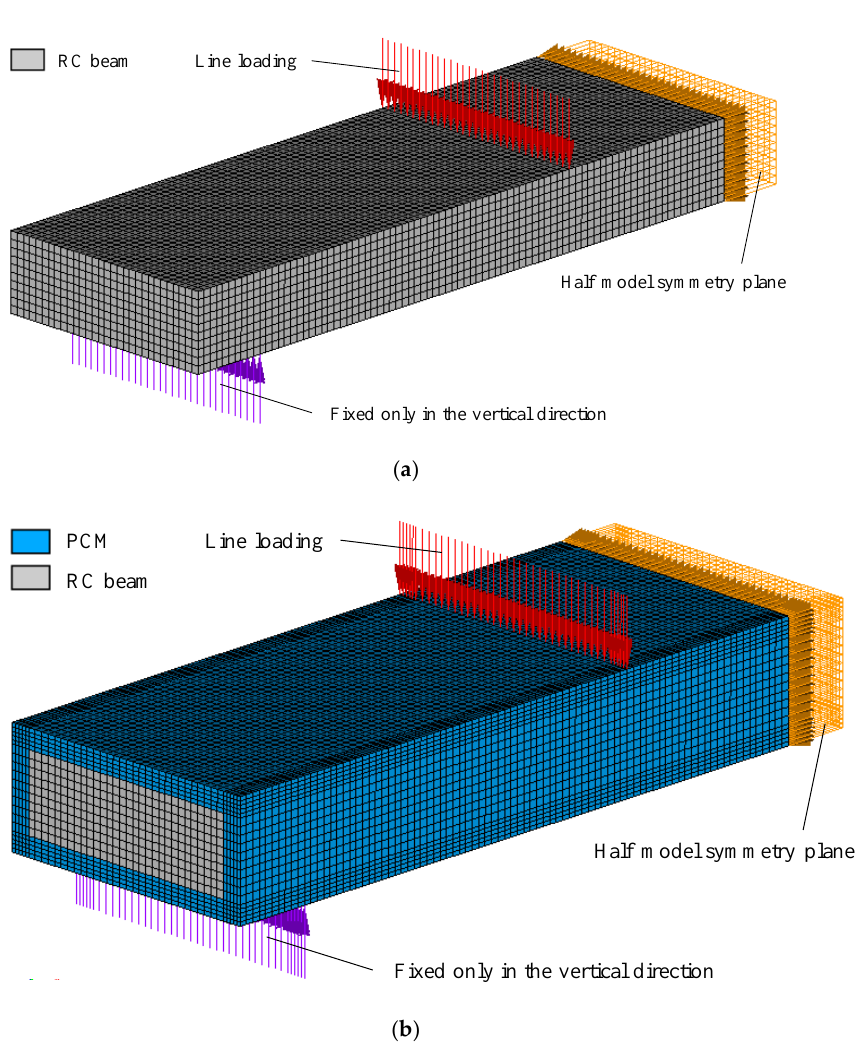
Figure 8. Analysis model: ( a ) RC specimen; ( b ) RPCM specimen model.